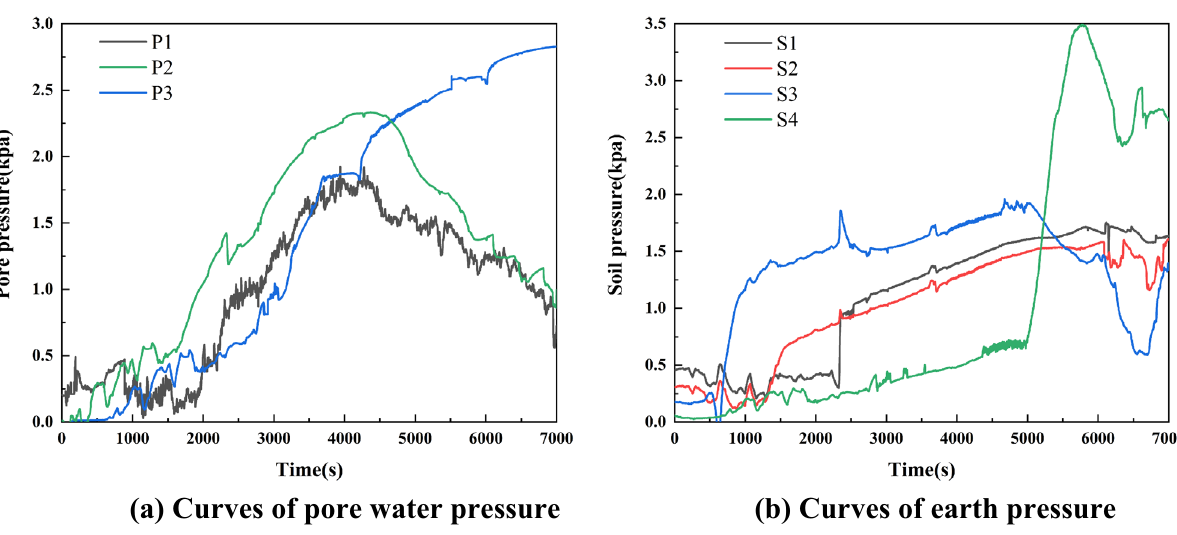
Figure 3. Stress response process of a